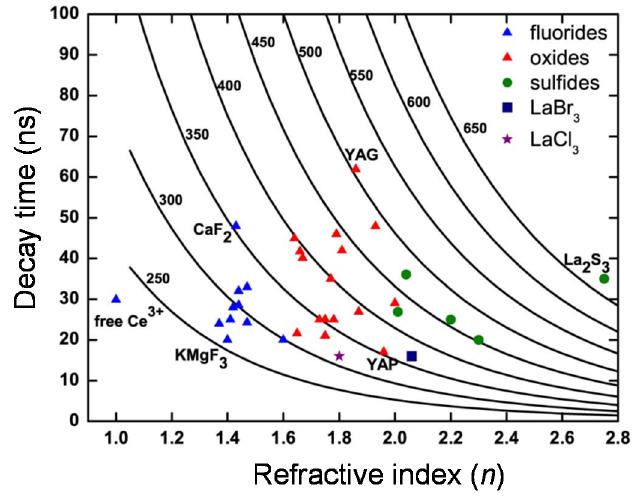
Figure 10. Predicted decay time as a function of the refractive index of the host compound for different 5 d –4 f Ce 3+ emission wavelengths. Data on various fluoride, chloride, bromide, oxide, and sulfide compounds are shown. Reproduced from [148] with permission.